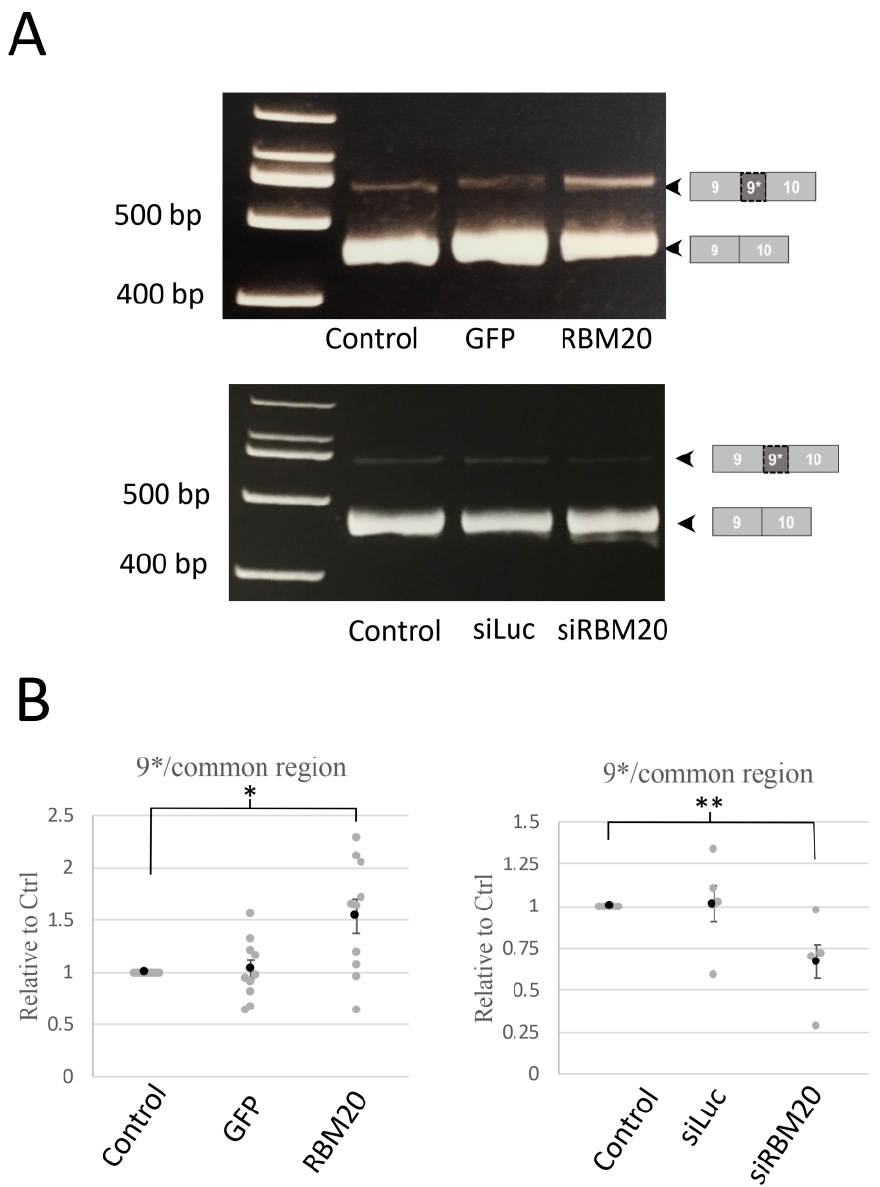
Figure 2. Manipulation of RBM20 expression modulates exon 9* splicing. Splicing of exon 9* was monitored by RT-PCR and RT-qPCR amplification of cardiomyocyte total mRNA. ( A ) Pictures of RT-PCR reaction resolved on an 8% PAGE gel. Amplicons are a region between exons 9 and 10, including or excluding exon 9* in the control, GFP, and RBM20-overexpressing cardiomyocytes ( upper ) or in the control, luciferase-1-targeting siRNA (siLuc), and siRNA-targeting RBM20 (siRBM20)-treated cardiomyocytes ( lower ). Pictures are representative of RT-PCR experiments from total RNA preparation extracted from neonatal rat cardiomyocytes ( n = 5). ( B ) Graphs show the ratio of exon 9*, including the region over common regions (exons 19–20), of quantitative RT-PCR amplification in control, GFP, and RBM20-overexpressing cardiomyocytes ( left , n = 10) or luciferase-1-targeting siRNA (siLuc), and siRNA-targeting RBM20 (siRBM20)-treated cardiomyocytes (right n = 5). Data are mean and SEM (gray circle) and individual data (gray circle); ** p < 0.01, * p < 0.05.